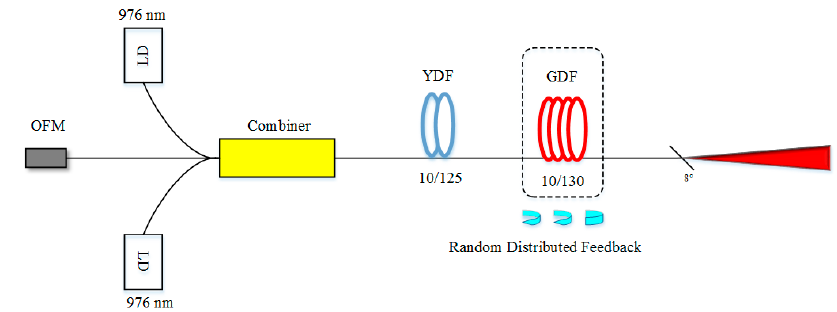
Figure 5. Experimental setup of the super-continuous (SC) source. LD, laser diode; OFM, optical fiber mirror.